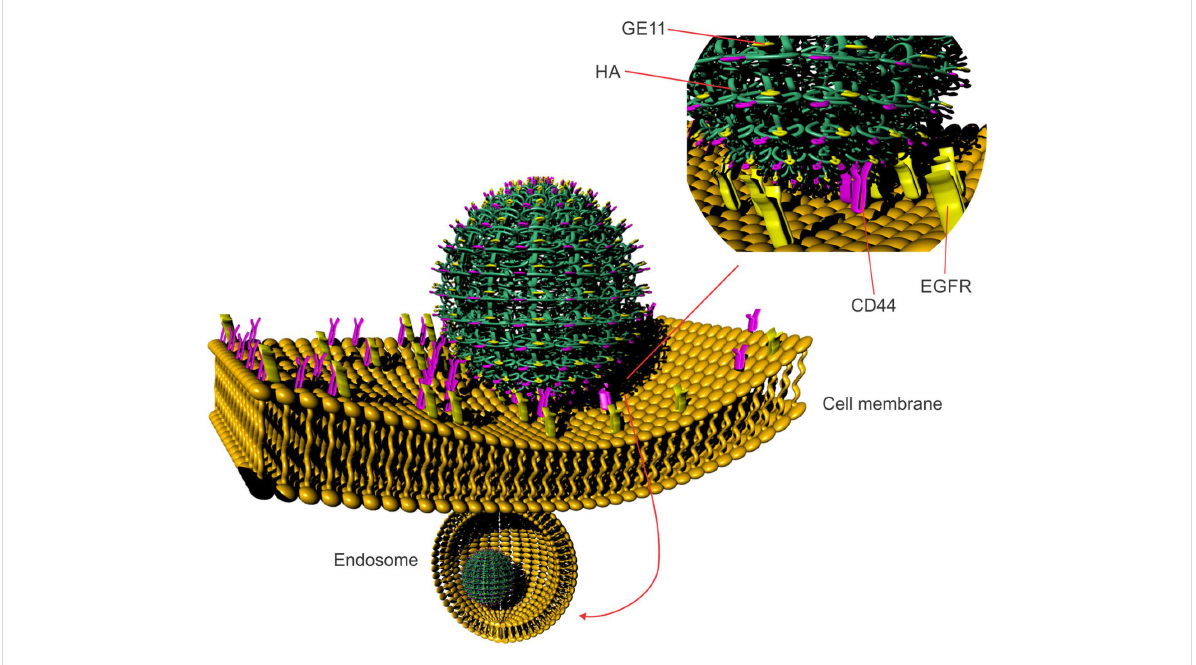
multifunctional hyaluronan nanogels targeting EGFR and CD44 (EGFR/CD44-NGs) (Figure 5). Their flow cytometry assay results pointed to a sixfold improved uptake of the